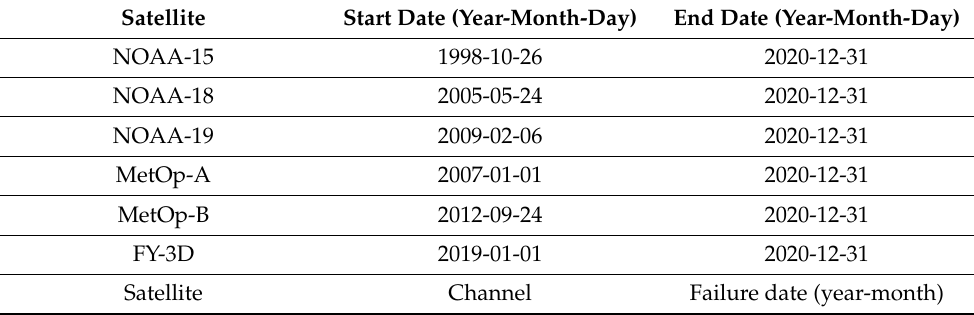
Table 2. Time periods of microwave data used in this study from different satellites and their failed